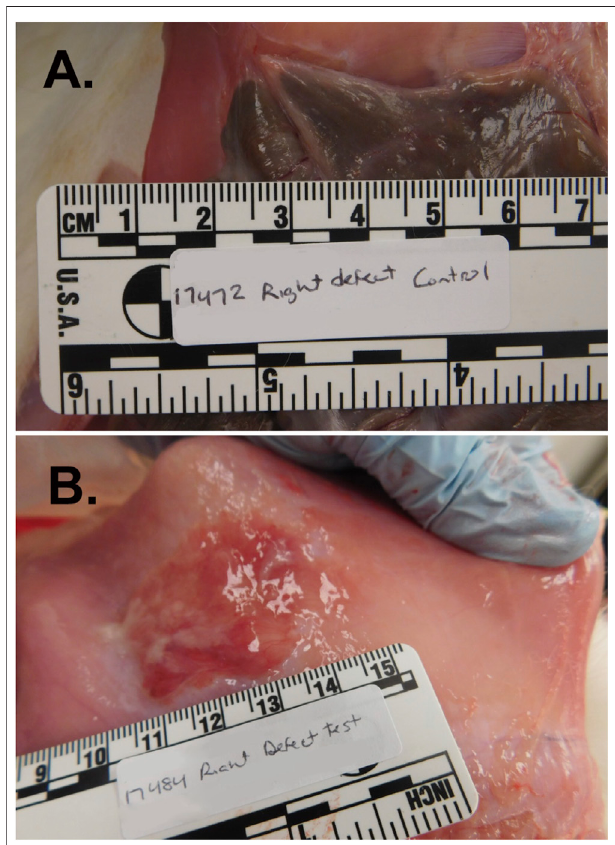
FIGURE 2 | Abdominal adhesion formation at the cecal serosa/ peritoneal junction in the rabbit cecal sidewall injury model. This model predictably and quickly generates robust abdominal adhesion formation, with grossly visible adhesions typically present by 7 – 14 days after surgery. Brie fl y, the abdominal cavity was accessed through a 12-cm ventral midline incision and bleeding injury was induced on the cecal serosa by abrasion with a sterile dry gauze pad and on the juxtaposed peritoneal inner surface by shallow excision and scraping with a scalpel blade. Approximately ≈ 2 × 4.5 cm wounds were irrigated with saline and then either treated with topical administration of PuraStat solution or left untreated as Controls before midline incision closure and recovery. At postoperative Day 14, adhesions were signi fi cantly more numerous and sizeable at the cecum/peritoneum interface in Control [Panel (A) ] animals compared to PuraStat-treated animals [Panel (B) ] whose abraded tissue surfaces received 3 – 12 ml/lesion of PuraStat solution (2.5% RADA16) immediately after wound creation and just prior to abdominal closure. The mean ± SD Total Adhesion Score (average of the scores for extent + strength of the adhesions in both defects per animal) was signi fi cantly 76% lower in PuraStat-treated animals at 2.0 ± 3.0